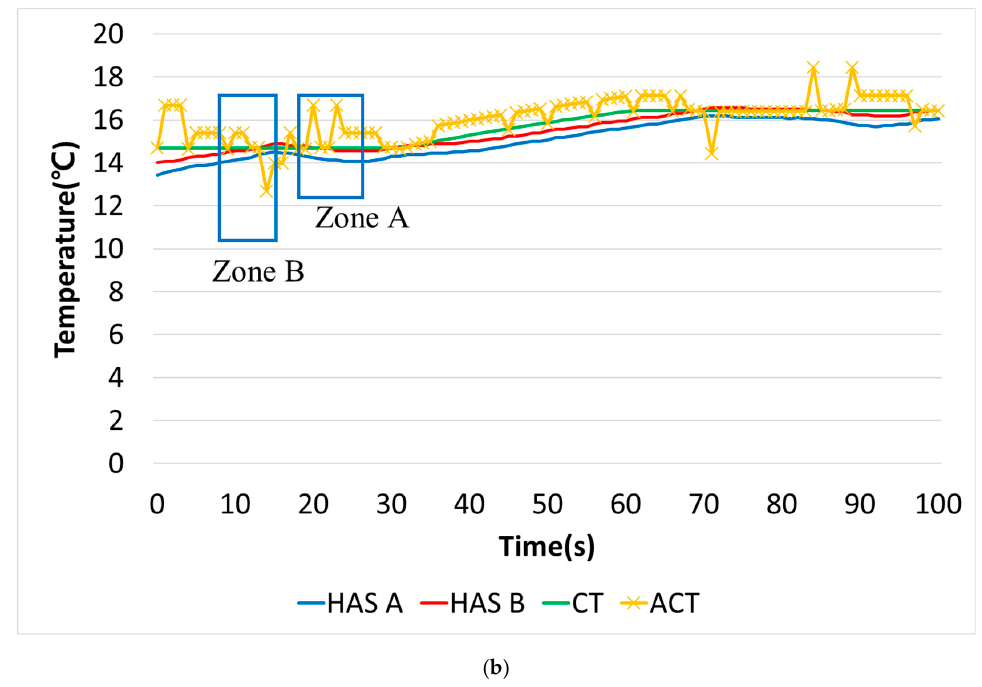
Figure 18. Response characteristics by condition of changing temperature and humidity. ( a ) PI Controller. ( b ) SF-PI Controller.